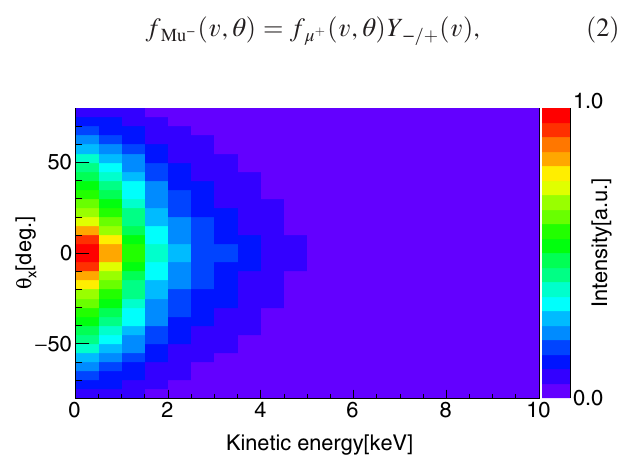
FIG. 4. Generated two-dimensional distribution for the Mu − ions in terms of the kinetic energy and the emission angle. The number of generated events is 10 6 events. The emission angle obtained by the horizontal direction of the momentum vector is drawn. The distribution in the vertical direction is similar.